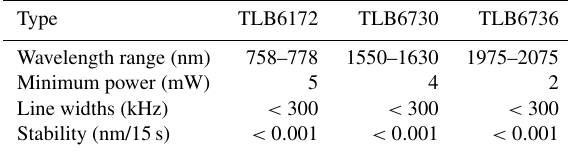
Table 2. Summary of the tunable diode laser